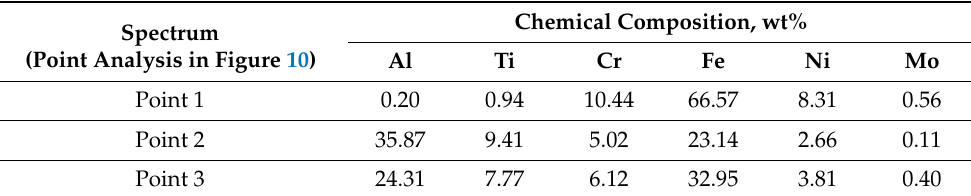
Table 4. The chemical composition of the phases within the microstructure of M789 maraging steel. Spectrum